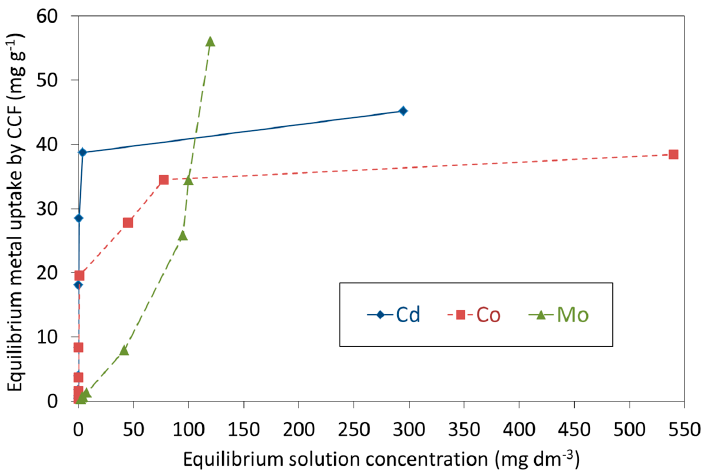
Figure 5. Equilibrium isotherm plots of the uptake of Cd 2+ , Co 2+ and MoO 42 − ions by CCF as a function of final metal ion concentration of the supernatant solution.